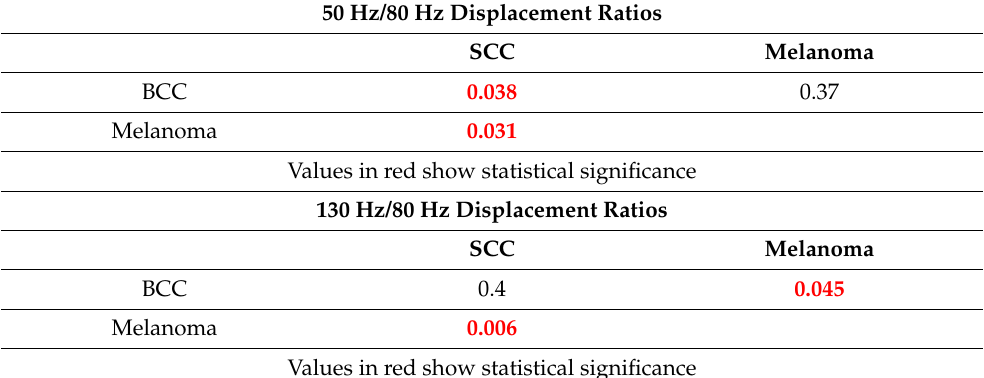
Table 2. Normalized ratios of 50/130 Hz and 80/130 Hz peaks for different skin lesions based on Figure 8. Note that BCC, SCC, and melanoma can be differentiated at a 0.95 confidence level (red) based on the peak ratios of 50/80 and 130/80 normalized peak heights using a two tailed Student’s t